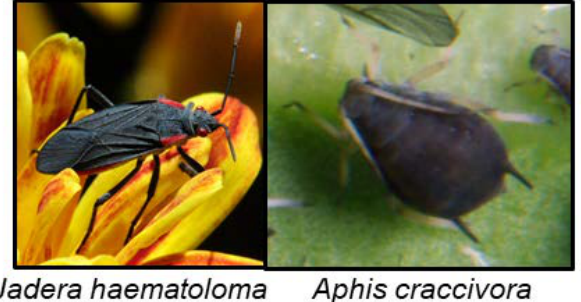
Figure 11. J. haematoloma photo by Louis J. Bradley ( https://commons.wikimedia.org/wiki/ File:Red_Shouldered_Bug,_Ant,_Mum.jpg ) and A. craccivora photo by David Perez ( https://commons.wikimedia.org/wiki/File:Aphis_craccivora_01_by-dpc.jpg